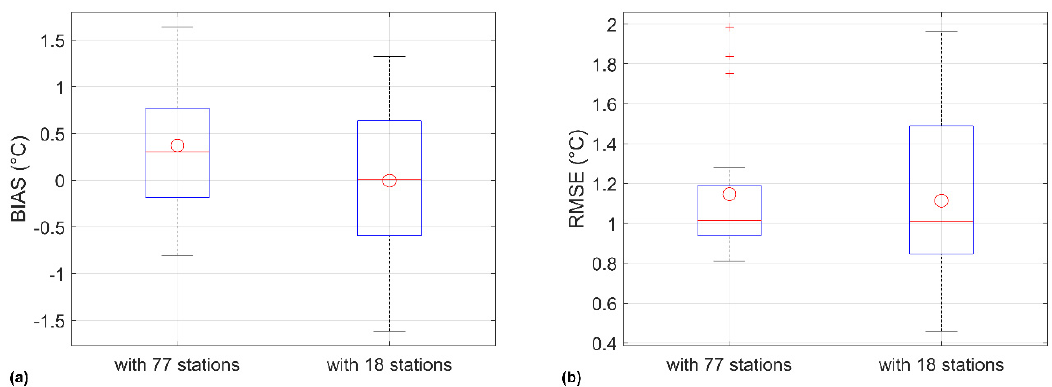
17 of 21 Figure A1. Eighteen ground weather station sites (red triangles) and 59 ground temperature station sites (orange triangles): 77 stations in total. Figure A2 shows boxplots of BIAS and RMSE of the temperature estimates at each of the 18 AWSs obtained with kriging estimates recursively conditioned to the air temperature observed at the residual 76 stations and 17 stations, respectively, according to the cross ‐ validation procedure. In the former case, the mean BIAS is 0.37 °C, ranging from − 0.80 °C to 1.64 °C; the RMSE is on average 1.11